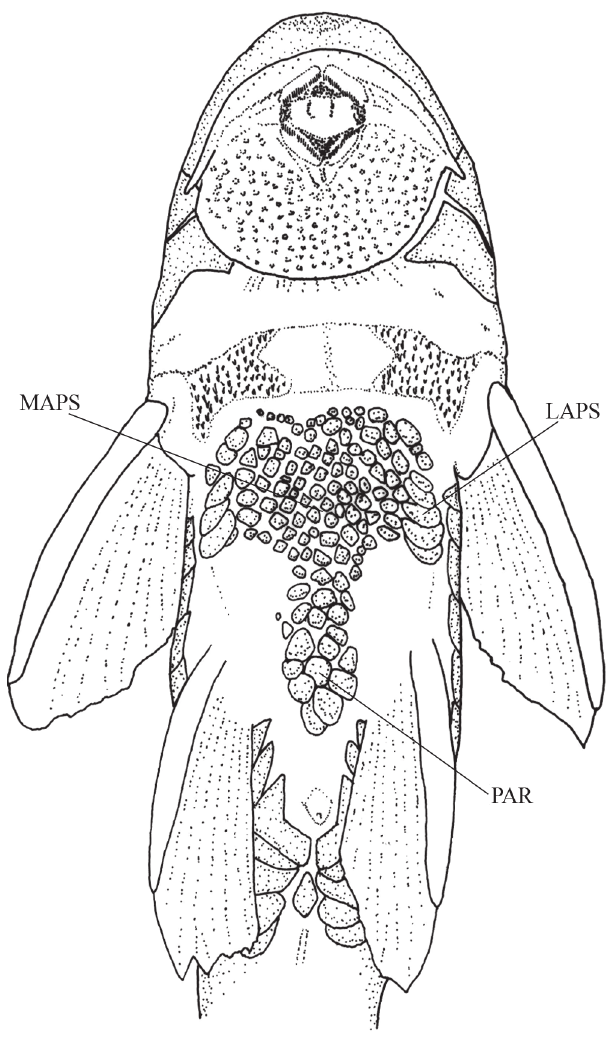
Fig. 5. Ventral view of abdominal region showing the lateral plates and preanal platelets arranged in T-shape in Parotocinclus spilurus. Abbreviations: LAPS, lateral abdominal plates series; MAPS, median abdominal plate series; PAR, pre-anal region.